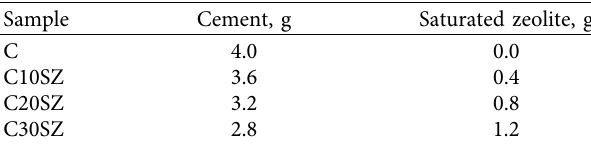
Table 2: Mix proportions of